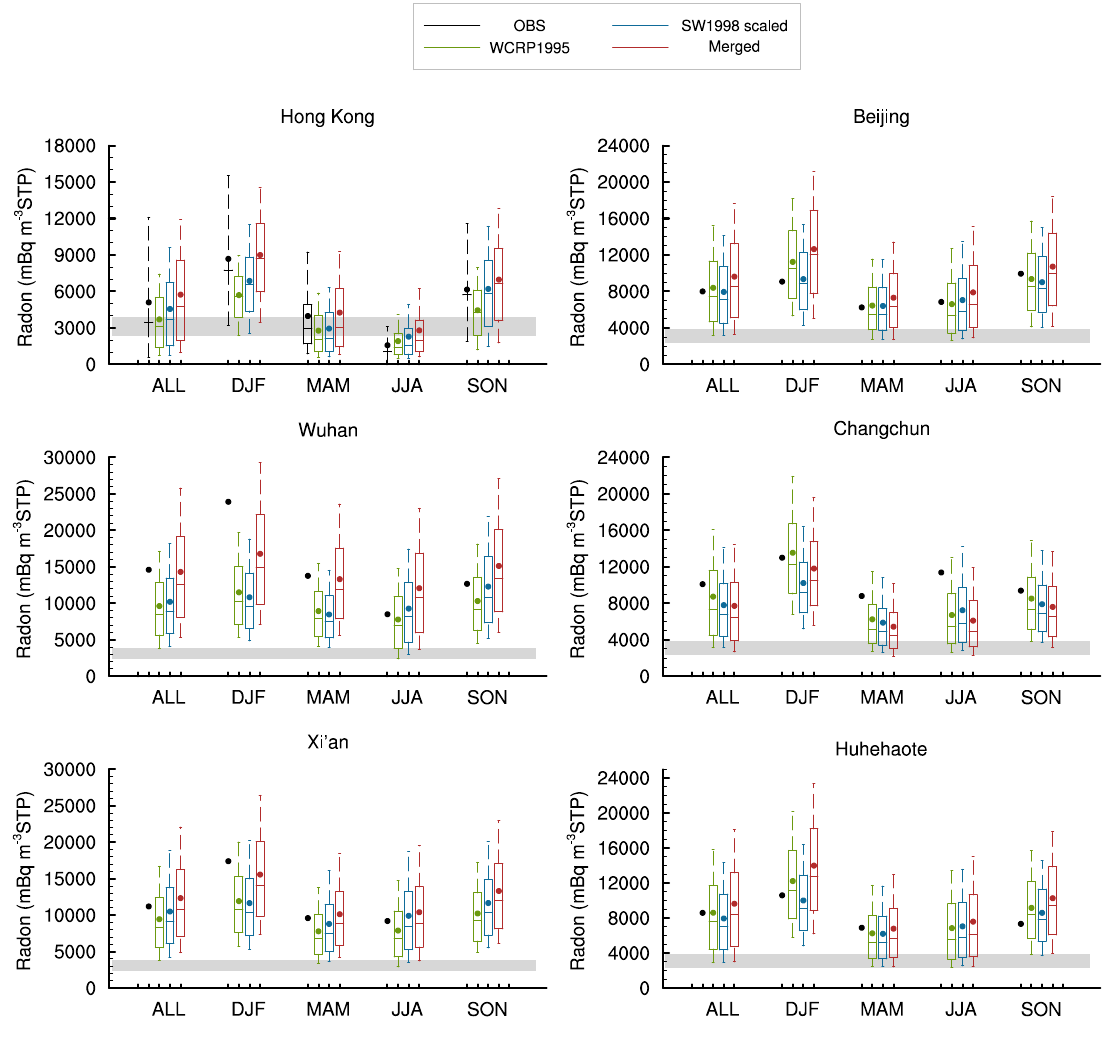
Fig. 8. Same as Fig. 7 but for six sites in China.